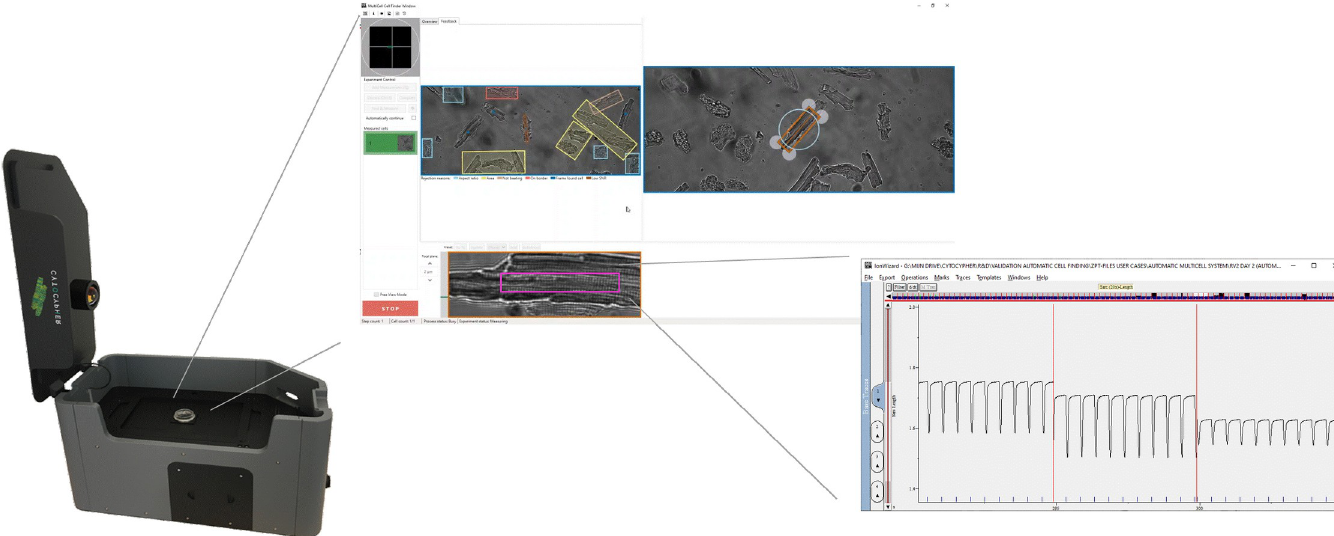
Fig 1. Illustration of the MultiCell high throughput system. A 35mm dish is placed in the microscope, MultiCell user interface showing the automatic cell finding feedback and the IonWizard acquisition window with sarcomere length